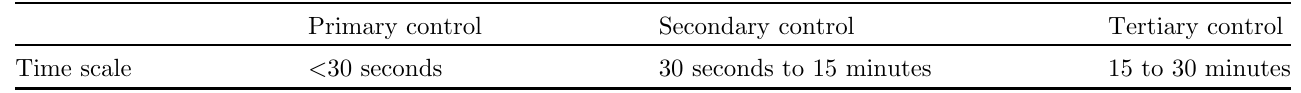
Table 1. Frequency control time-scale comparison